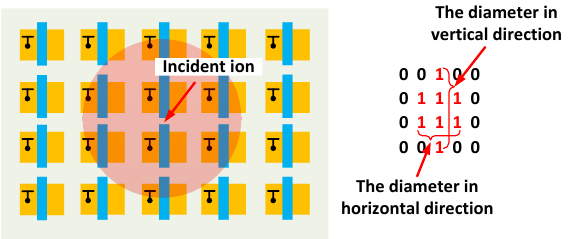
Figure 3. TAISAM can be used to determine the diameter of the ion-induced sensitive